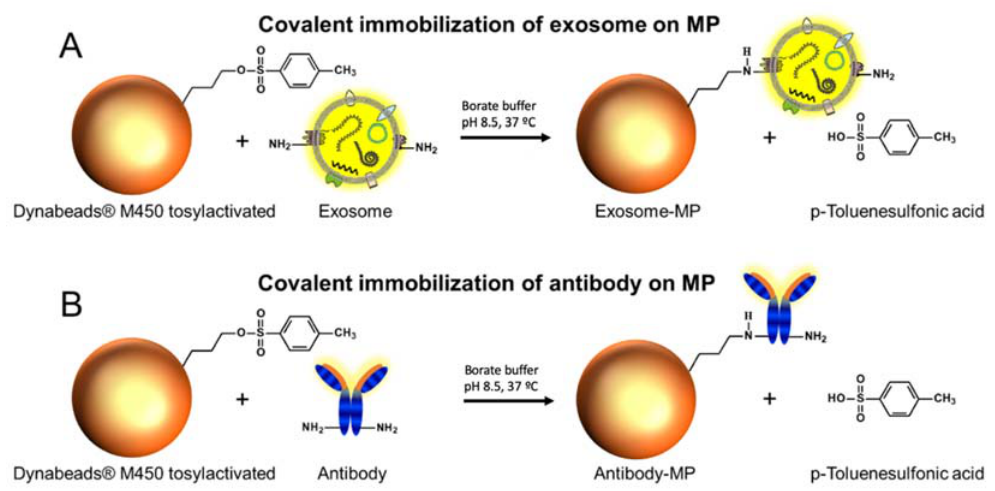
Figure 2. ( A ) Direct covalent immobilization on Dynabeads ® M450 tosylactivated. ( B )